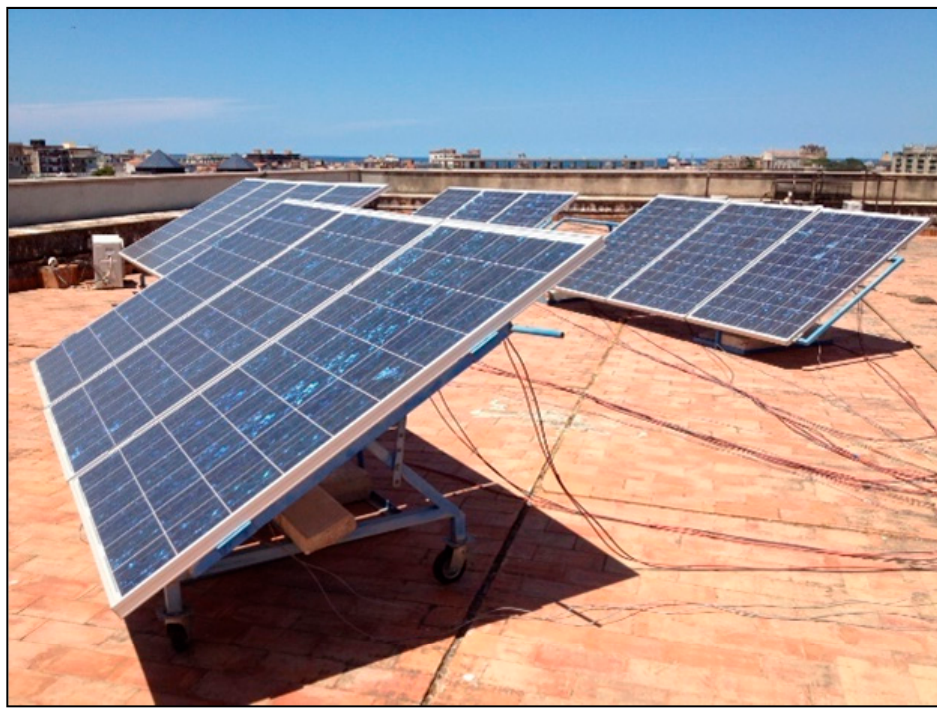
Table 9. Electrical characteristics in different load conditions evaluated by reconfigurator for each Figure 7. Experimental system with panels individually connected to DRS. Figure 7. Experimental system with panels individually connected to DRS. panel.